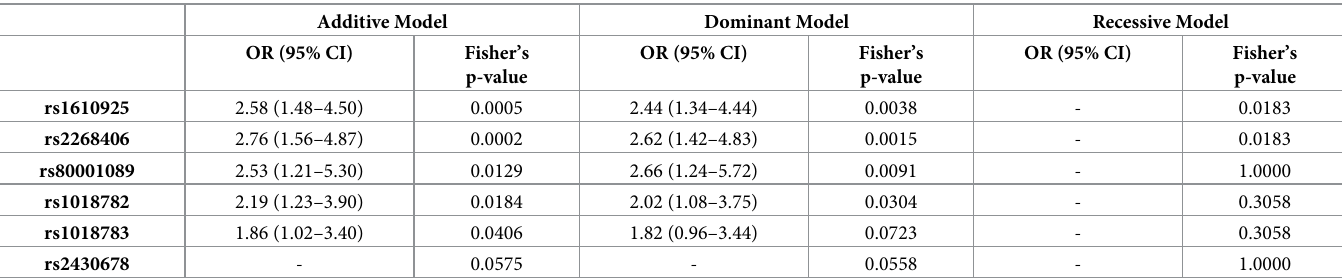
Table 5. Analysis of gene variants in blood samples based on genetic models.